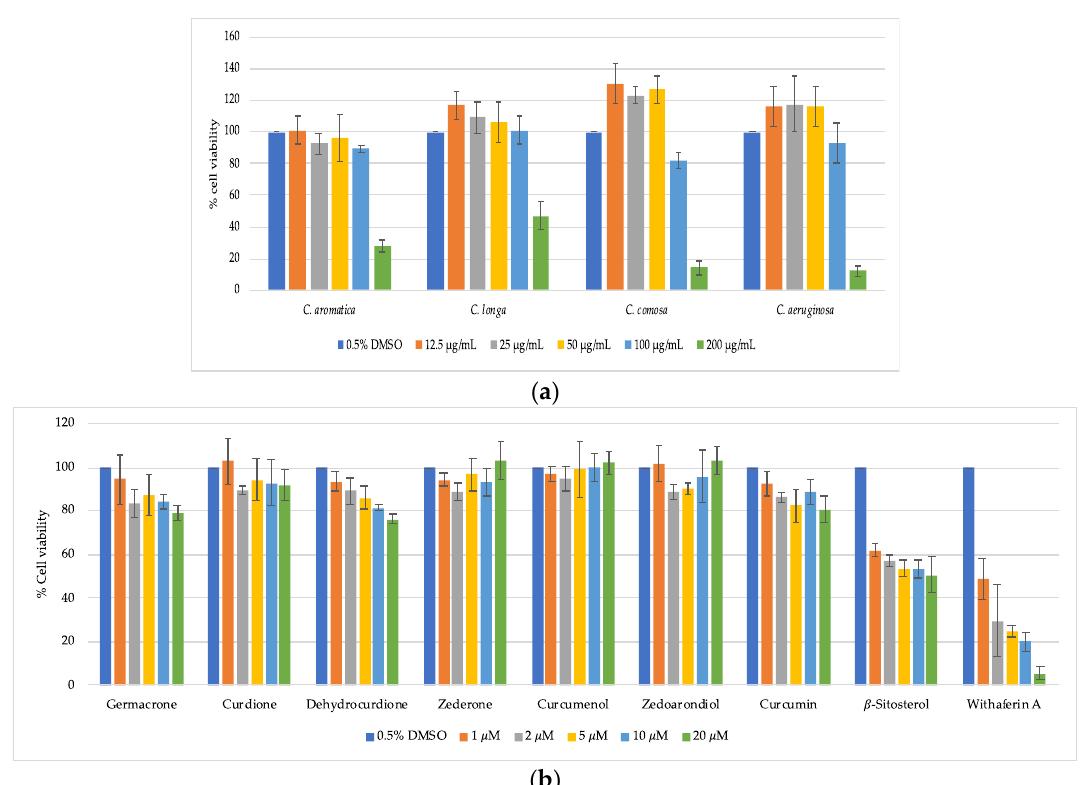
Figure 3. ( a ) Relative HaCaT viability by increasing concentrations of four Curcuma species. ( b ) Relative HaCaT viability (%) by increasing concentrations of pure compounds isolated from C. aromatica and the reference cytotoxic anti-cancer compound withaferin A in HaCaT cells.